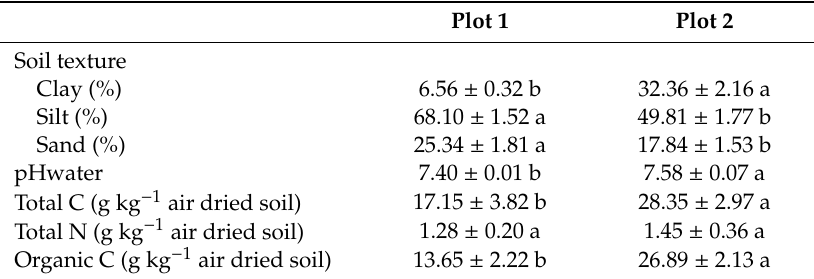
Table 1. Soil physicochemical properties in the two studied